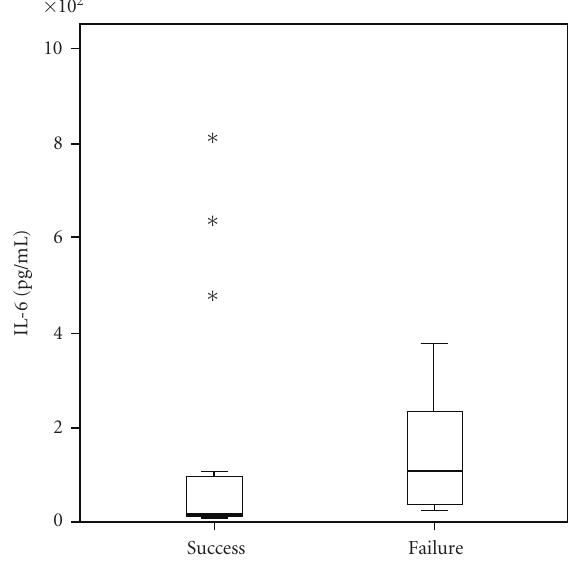
Figure 3: Aqueous levels of IL-6 in eyes with surgical success and failure 3 months after surgery ( P = . 031). Asterisks indicate the